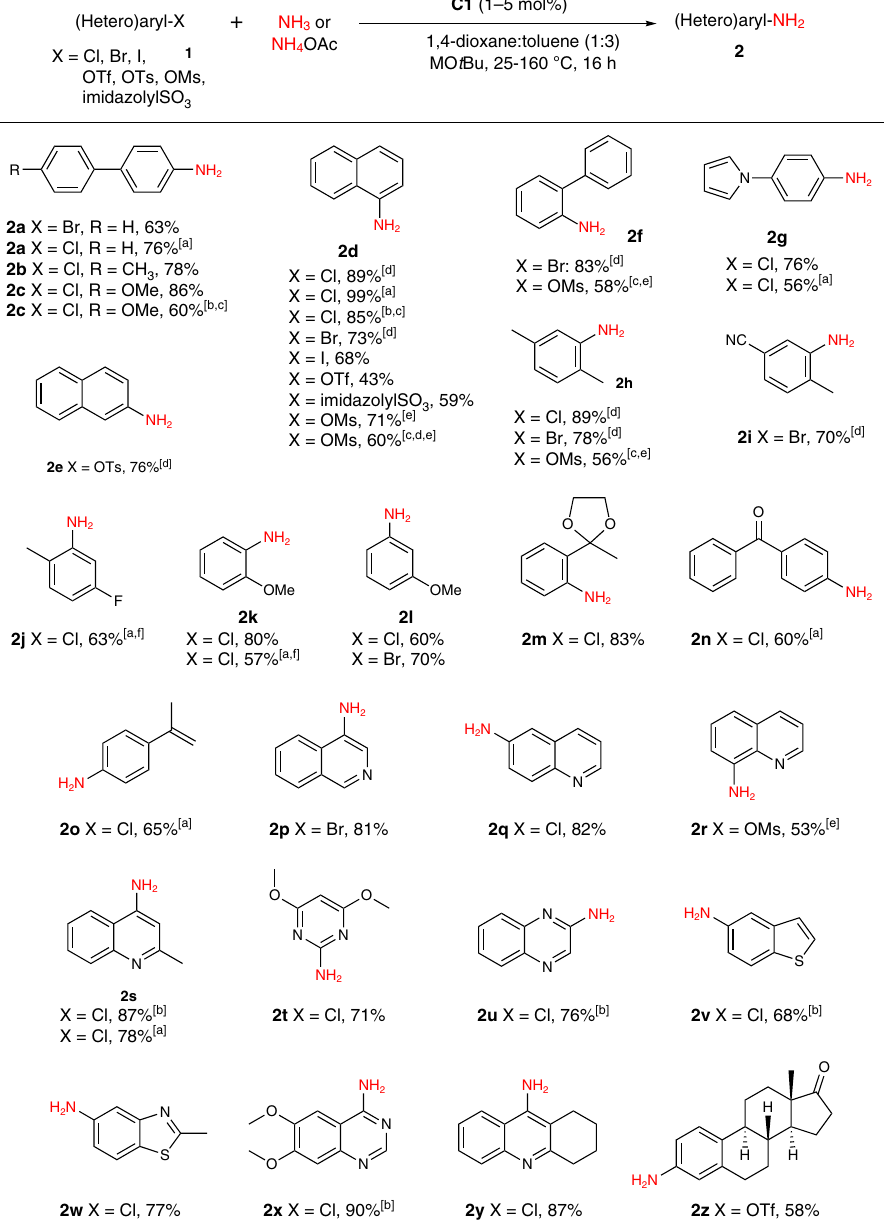
Figure 6 | Scope of ammonia monoarylation using C1. Unless stated otherwise, reactions were conducted employing C1 (1–5mol%), MO t Bu (M ¼ Li or Na; 1.5–2.0equiv), NH 3 (from 0.5M solutions in 1,4-dioxane; 3–8.3equiv), in toluene for 16h (unoptimized), with yields of isolated products reported; throughout, see the Supplementary Information for complete experimental details. [a] 110–160 (cid:2) C for 5–30min under microwave conditions using NH 4 OAc (5equiv) and NaO t Bu (6.5equiv) in CPME. [b] Conducted using gaseous ammonia (114psi initial pressure). [c] Yield on the basis of 1 H NMR data relative to ferrocene as an internal standard. [d] 25 (cid:2) C. [e] K 3 PO 4 (6equiv) used as base at 110 (cid:2) C without toluene co-solvent. [f] Isolated as the N -tosylated